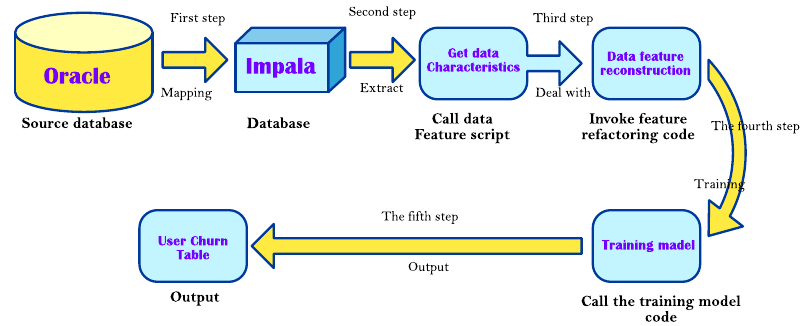
Figure 14. Application flowchart.